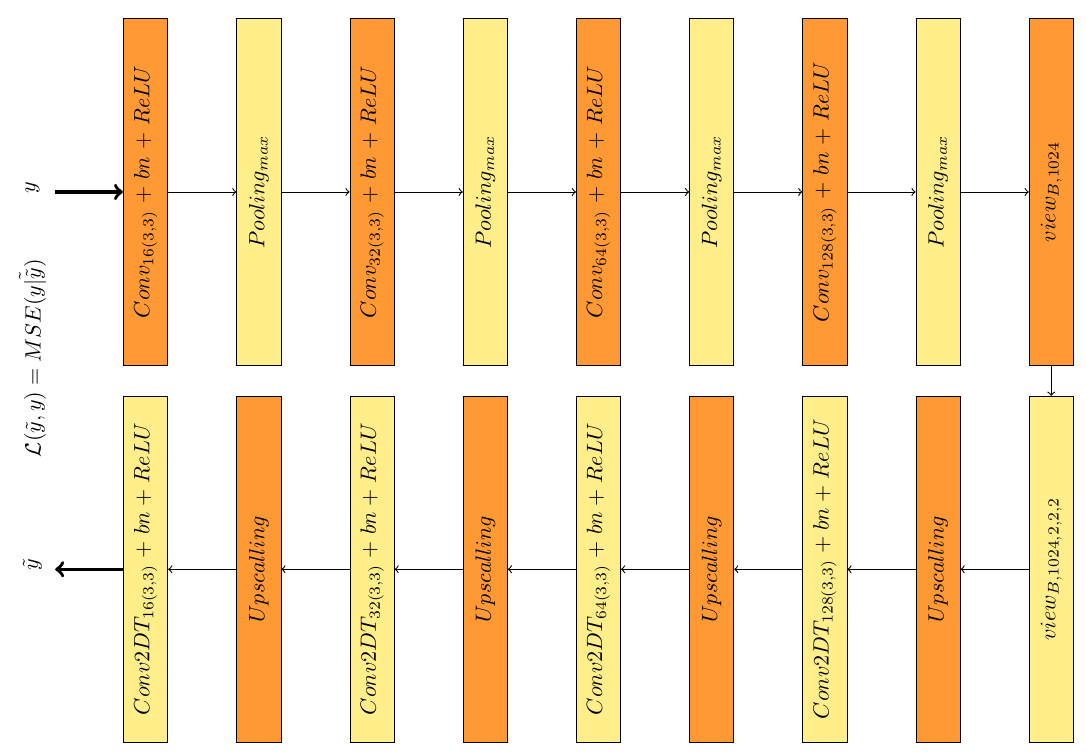
Fig. 2 Unseen detection module architecture (AE)